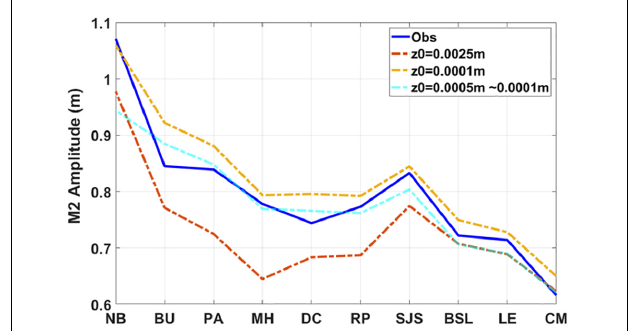
FIGURE 3 | Model calibration of bottom roughness based on M2 tidal